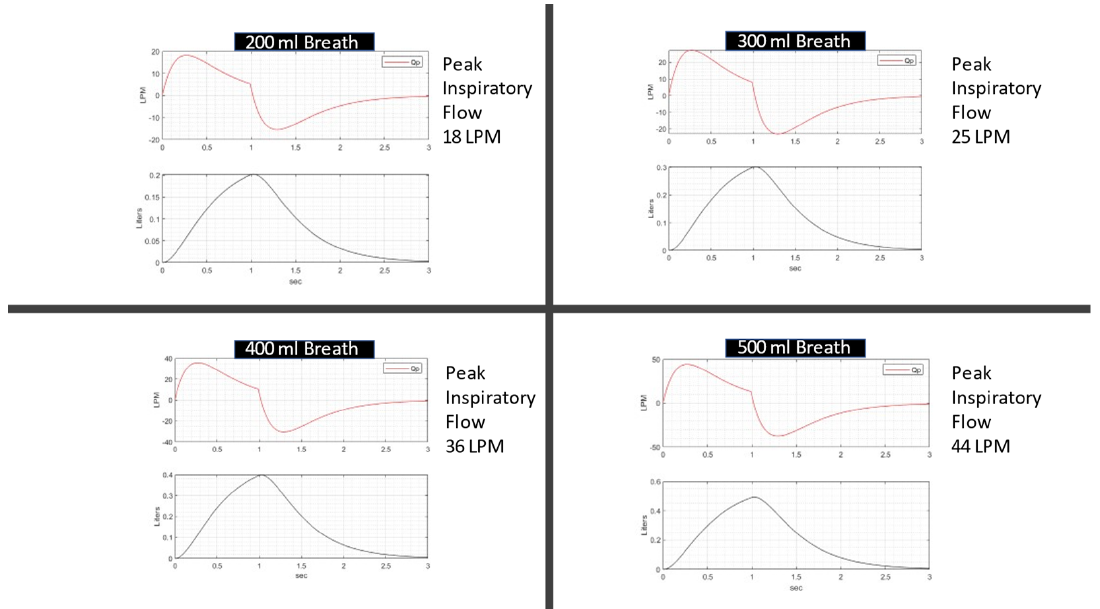
Figure 2. This figure illustrates four differing breath waveforms used throughout this analysis. Flow (Liters/min) is shown in the upper chart of each panel and volume ( Liters ) in the lower chart. The breath sizes range from a shallow 200 mL breath to a normal 500 mL tidal breath. The peak inspiratory flow is listed for each breath. It will become clearer below why the peak inspiratory flow is highly relevant to the clinical e ff ectiveness of the HFNT treatment.